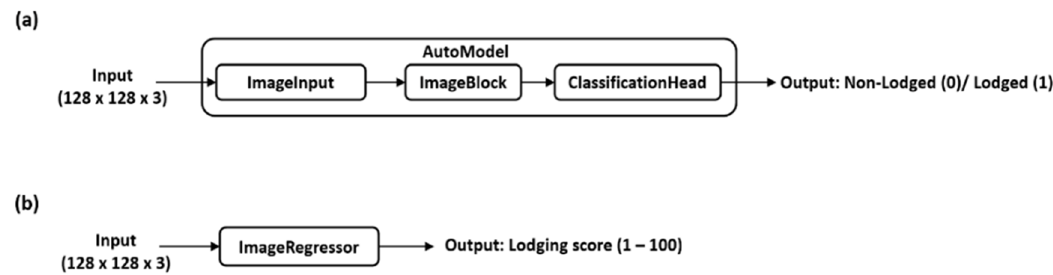
Figure 5. Automated machine learning with AutoKeras. ( a ) AutoModel for image classification. ( b ) ImageRegressor for image regression.